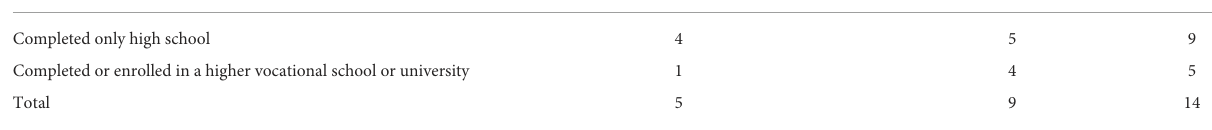
TABLE 2 Characterization of farmers’ education and vocational training. Level of education